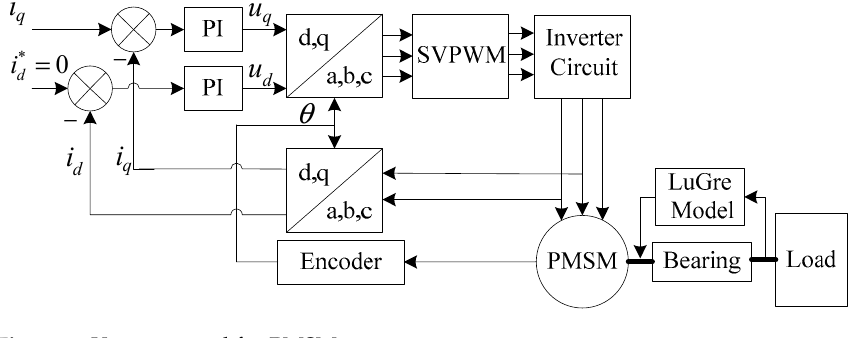
Figure 1. Vector control for PMSMs. Two current loops are included in the VC of the PMSM. By controlling i d = 0